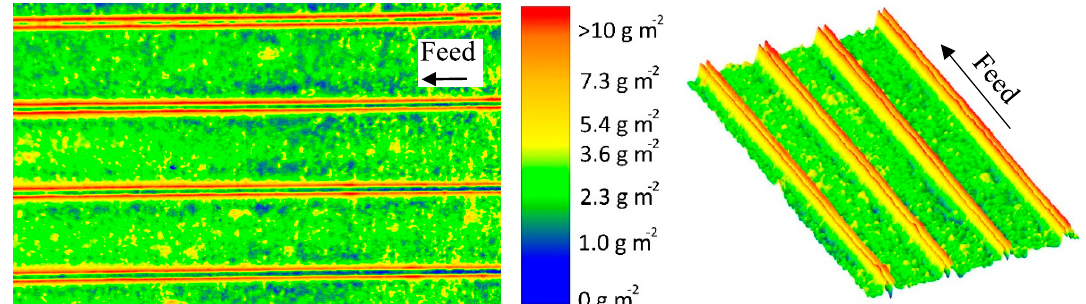
Figure 5. False color and topographic image of the deposit layer formed by a parallel spacer after filtration of concentrated skim milk (CF 3, Δ p L = 1.0 bar m − 1 , mean crossflow velocity of 0.14 m s − 1 , Δ p TM = 0.5 bar). The average amount of deposited protein determined by HPLC was 4.9 g m − 2 . The membrane after staining can be found in the Supplementary Material (Figure S3).